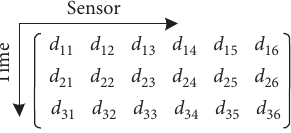
Figure 4: Time slot